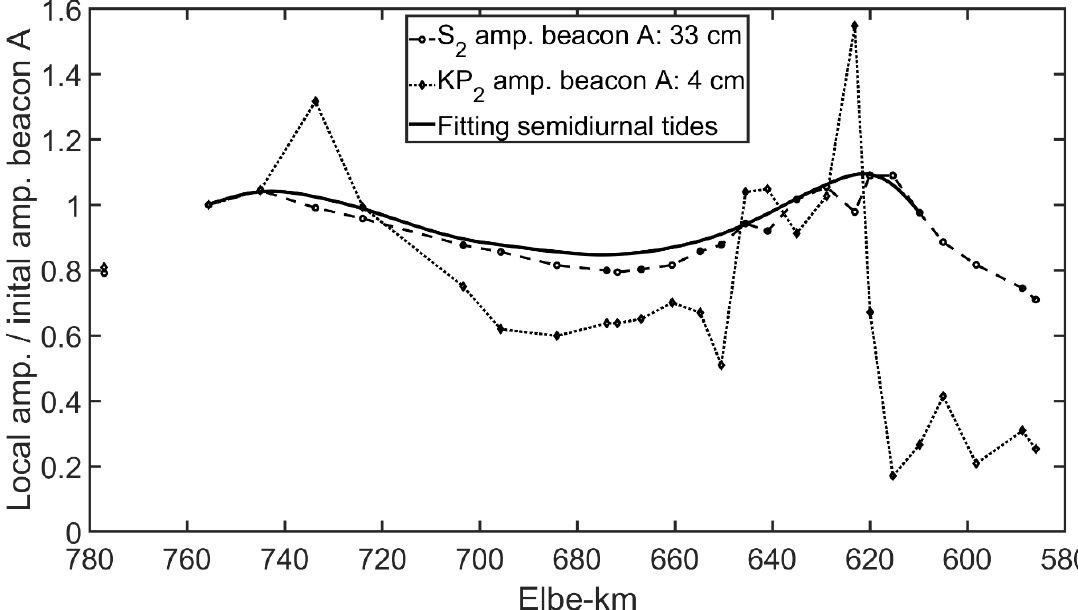
Figure 6. Tidal constituents S 2 and the shallow water compound tide KP 2 considering its nodal amplitude and phase correction. The fitting curve includes amplitudes of M 2 , S 2 and N 2 without consideration of compound tides.